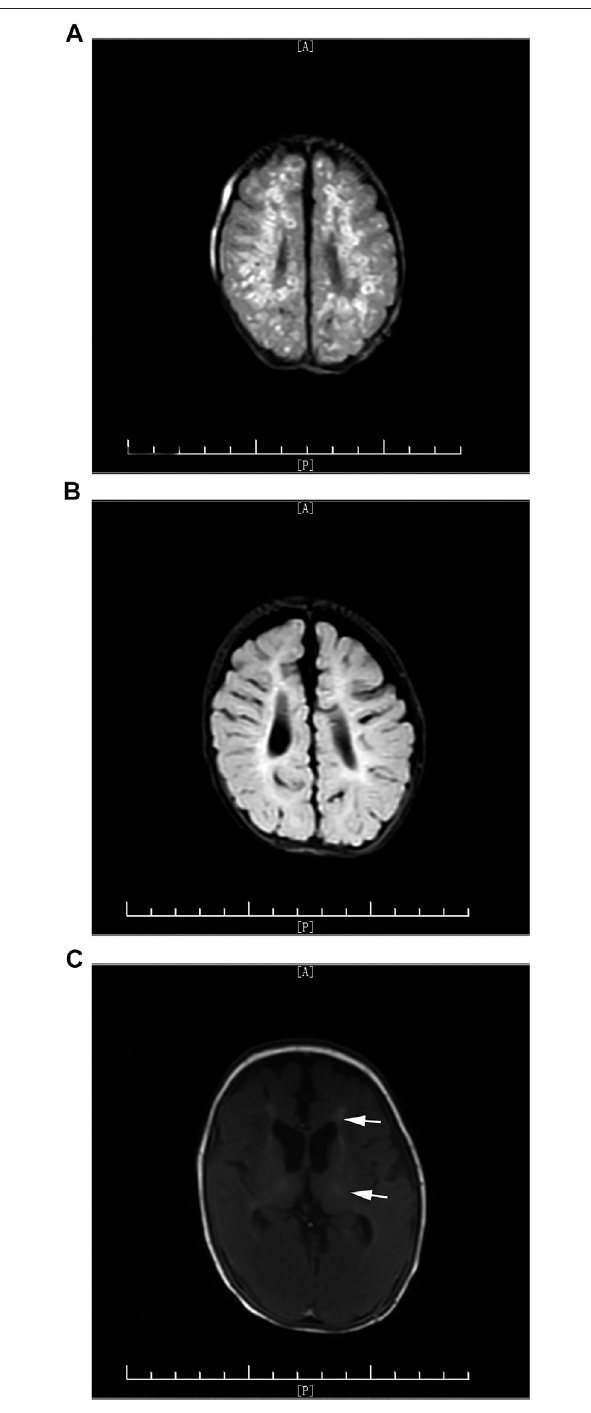
FIGURE 2 | (A) Multiple nodular and circle-enhanced signals in T2- FLAIR at 1 week after infection. (B) Clearance of enhanced signals before treatment was discontinued. (C) Arrows indicate paraventricular white matter injury in T1WI before treatment was